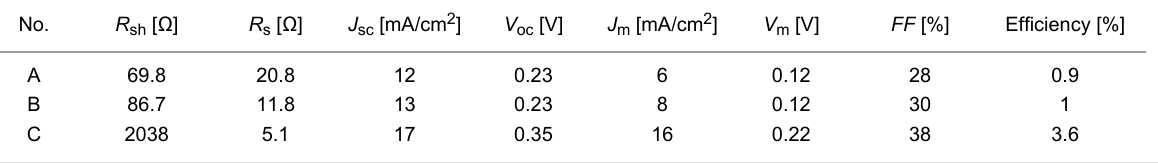
Table 3: Photovoltaic parameters for the investigated heterostructures.